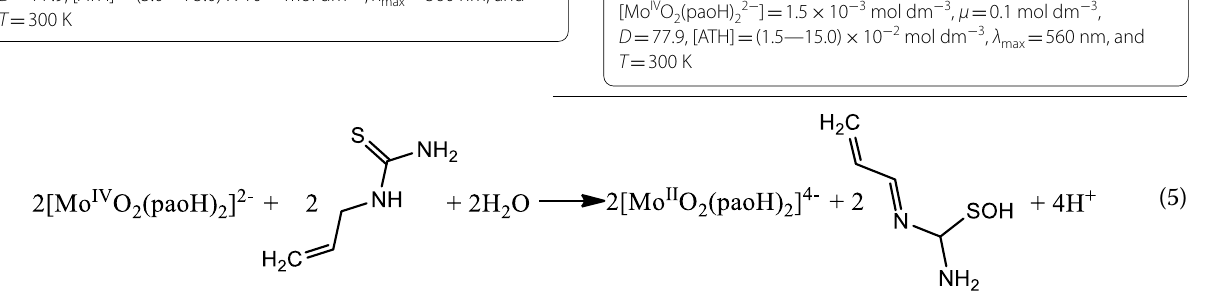
Fig. 1 Stoichiometric plot of the reaction of [Mo IV O 2 (paoH) 2 ] 2 − and ATH at [Mo IV O 2 (paoH) 22 − ] D